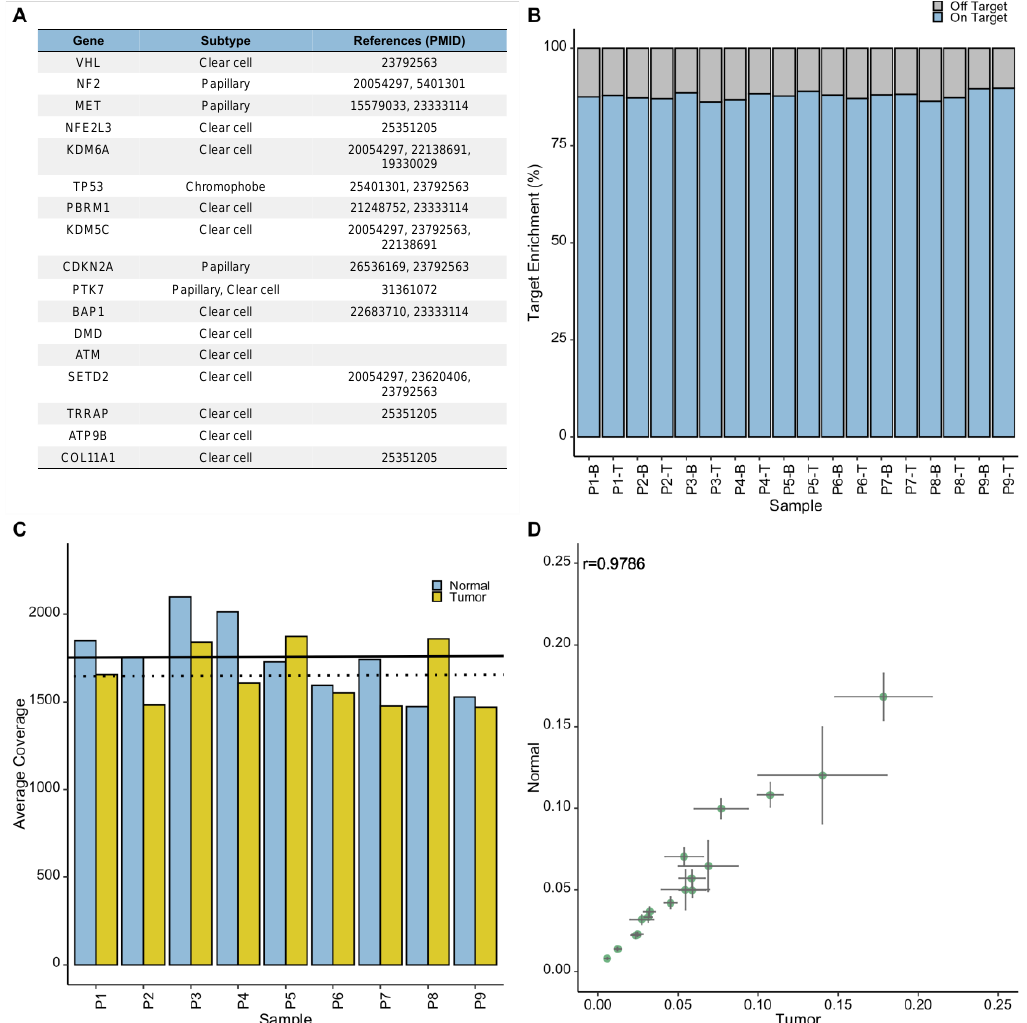
Figure 2. Development and evaluation of the RCC-appropriate NGS assay. ( A ) The RCC assay was designed to target genes that are commonly mutated in RCC tumors, have demonstrated prognostic value in RCC, or have shown association to treatment response in previous large-scale studies. ( B ) The assay showed high efficacy for capturing the targeted regions, with average on-target rates of 87.8% (SD of 0.01) across 18 samples, pooled together prior to the capture. ( C ) Average sequencing coverage is shown for the same 18 samples (9 tumor-normal pairs), included in a given hybridization capture, with average sequencing coverage depths of 1646 × and 1753 × of the targeted regions for tumor (dotted line) and normal (solid line) DNA samples, respectively. ( D ) High Pearson’s correlations (r > 0.97, p < 0.0001) between gene-specific proportions of sequencing reads from tumor and normal samples demonstrates that assay performance is not biased by sample type. Error bars show SD within sample types. SD: standard